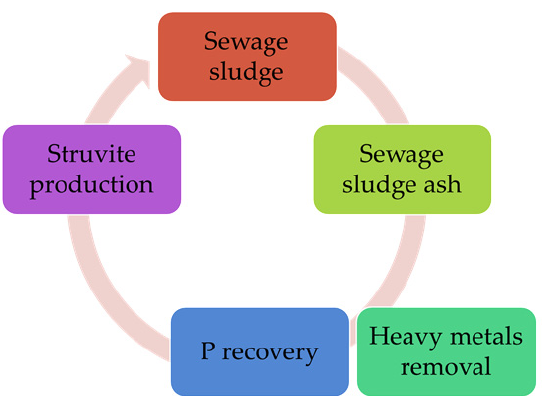
Figure 2. Scheme of struvite formation according to the circular economy concept.